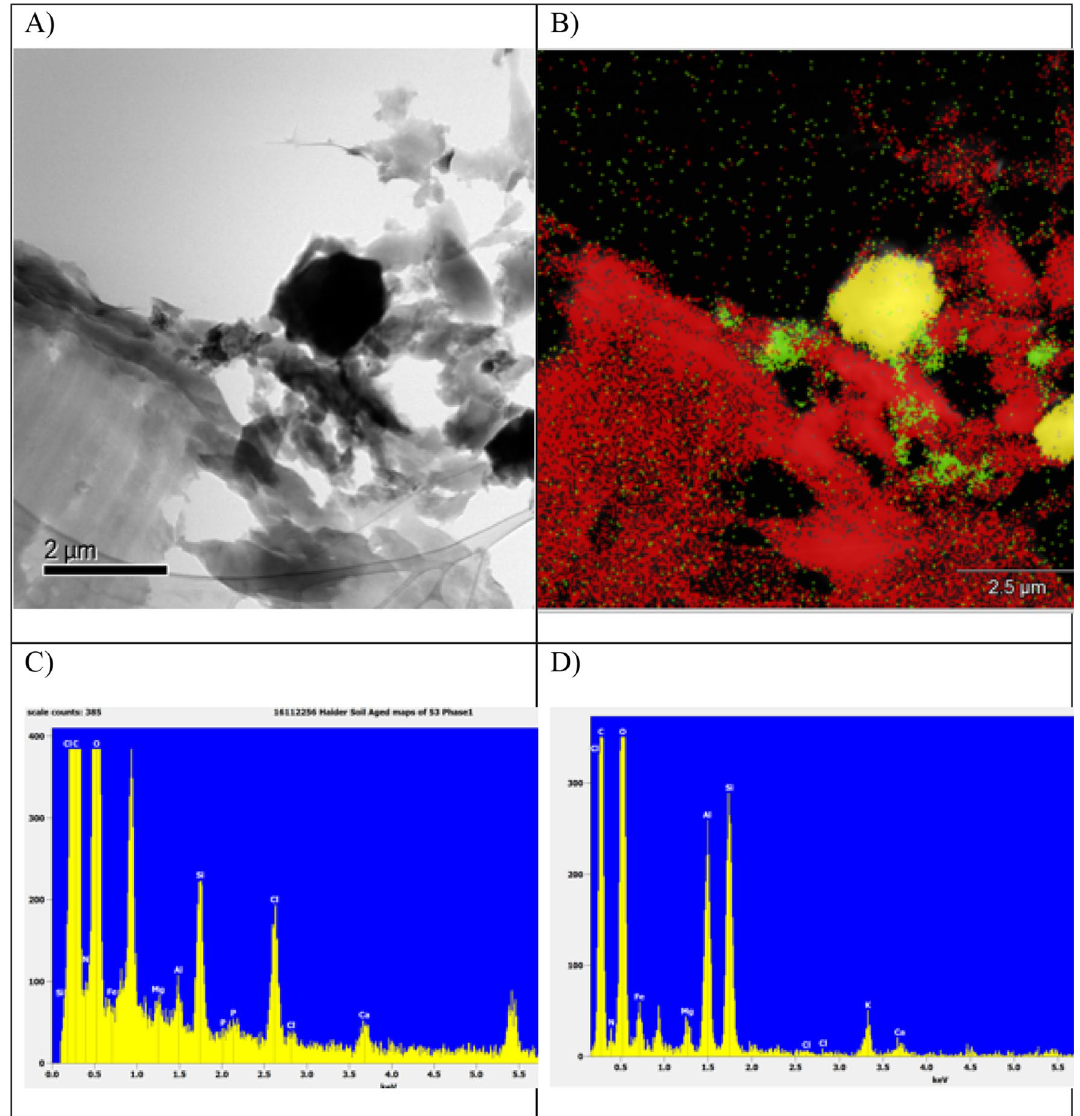
Figure 5. Image ( A ) is the bright field image of the surface of the aged biochar; ( B ) is the EDS phase map of image A (where red is a high carbon phase and yellow is a high silicon phase; ( C ) is the EDS map of red phase showing that minerals containing Si, Cl, Ca, Fe, Mg, and Al are associated with the carbon matrix; ( D ) is the EDS spectrum showing that the N is associated with mineral high in Al, Si, and Fe (probably